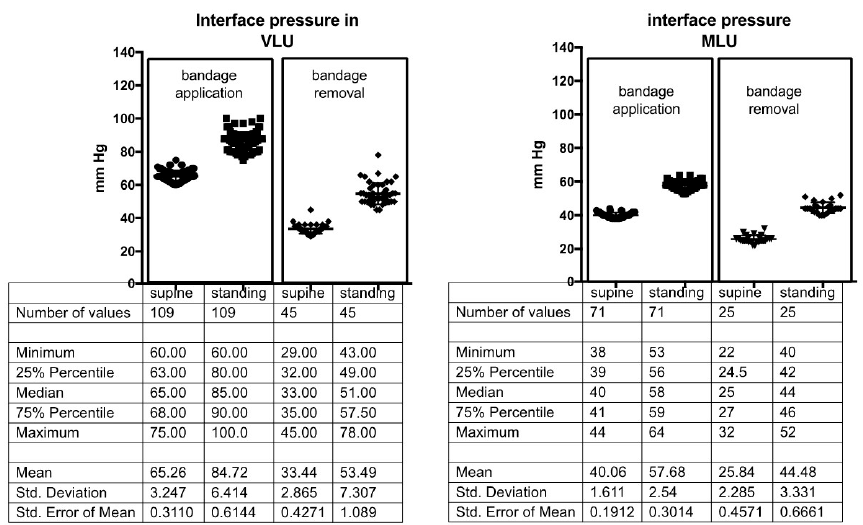
Figure 4. Compression pressure values in supine and standing position both at application and at removal of the bandages in patients with Venous Leg Ulcers and with Mixed Leg Ulcer.